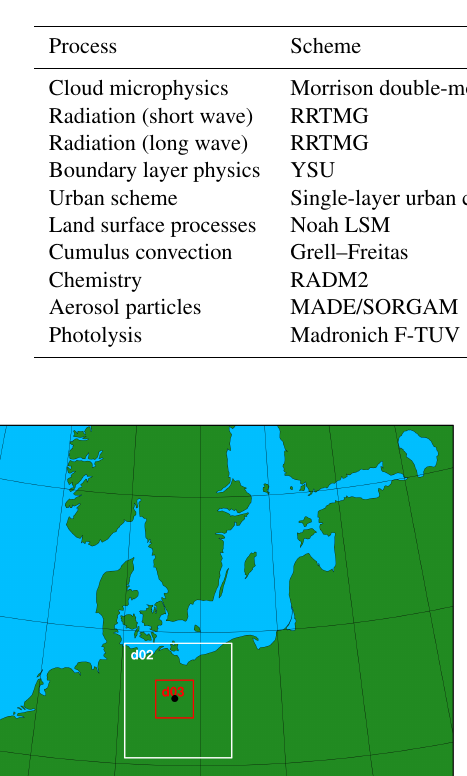
Table 1. Physics and chemistry parameterisation.